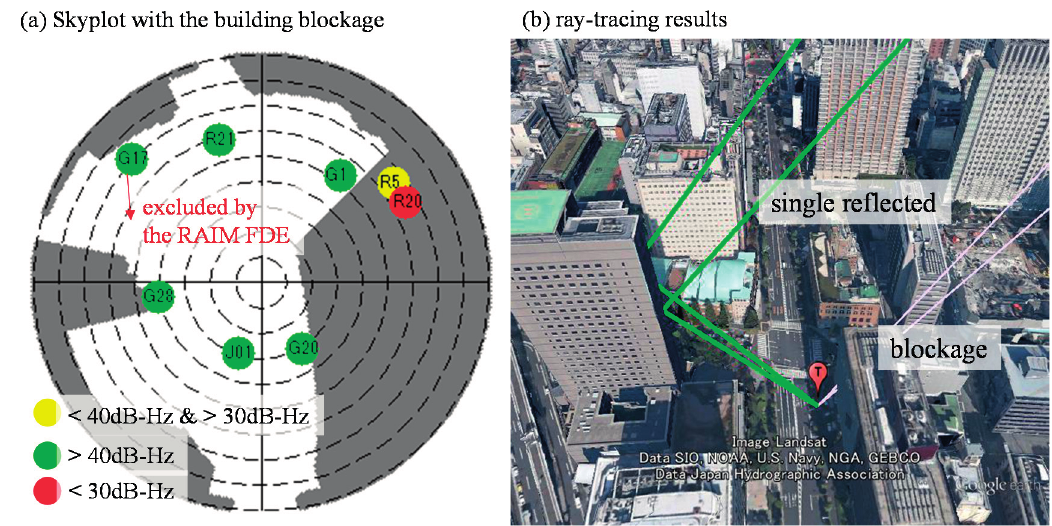
Figure 11. ( a ) Skyplot of point 264,308, and the dark grey color indicates the view blocked by surrounding buildings; ( b ) Ray-tracing result of point 264,308 based on the ground truth